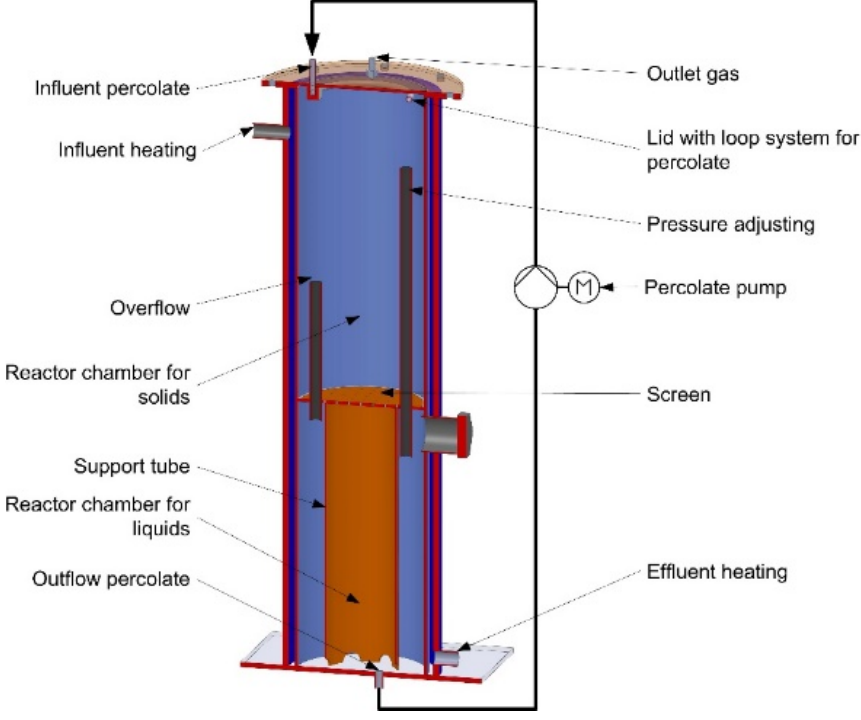
Figure 2. Schematic of percolate digester (dry digestion system) (Stur, Deutsches Biomasseforschungszentrum gGmbH (DBFZ)).